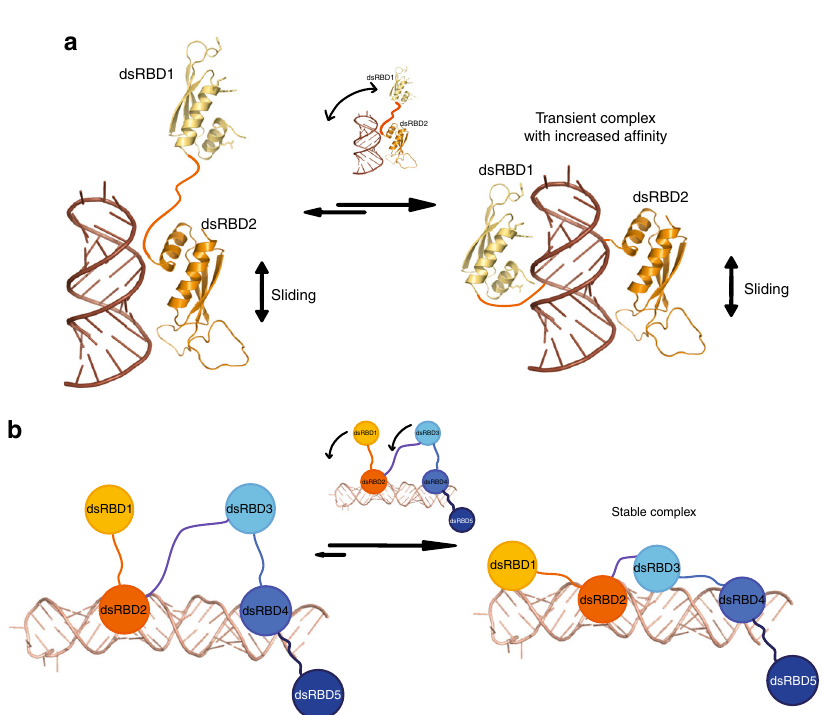
Fig. 6 Functional interaction of mStau2 with oskar mRNA in Drosophila . a Expression of GFP-dmStau, GFP-mStau2, GFP-mStau2[F40A H169A] and GFP- mStau2[F40A F157A] in germline of stau R9 /stau D3 mutant females. In dmStau-expressing oocytes oskar (cyan) localizes almost exclusively to the posterior pole (right) and bicoid (green) to the anterior pole (left) during stage 9 of oogenesis. Transgenic GFP-Stau protein is shown in red. In oocytes lacking Stau ( stau null), oskar is found at both poles, enriching slightly more at the anterior, while bicoid localization is unaffected. Insets show magni fi ed regions of the upper anterior corner. Scale bar: 20 µ m and 1 µ m for insets. b Typical localization of oskar mRNA in oocytes as function of expressed Stau protein. Using image transformation algorithms, RNA signal was redistributed into a 100 × 100 square matrix and statistically evaluated to obtain average (green) and variability (magenta) of RNA distribution. In wild-type oocytes (top left) most signal is found close to the posterior pole (right of the panels) by stage 9. In absence of Stau (stau null), oskar mRNA accumulates at the anterior pole. Scale bar: 20% length of anteroposterior axis. c , d Center of mass (relative to geometric center at 0, c) and fraction at posterior pole of oskar mRNA ( d ) during stage 9. P -values show result of pairwise Mann – Whitney U tests vs. the stau null condition (Bonferroni corrected alpha value: 0.01). N = number of oocytes. Center line: median; box limits: 25 th and 75 th percentile; whiskers: 10 th and 90 th percentile. e – h Interaction of GFP-tagged Stau molecules with oskar ( e , f ) and bicoid ( g , h ) mRNPs. mRNPs are sorted by their mRNA content using quantitative smFISH. Fraction of Stau positive mRNPs ( e , g ) and normalized GFP-Stau signal intensity ( f , h ) were plotted as function of mRNA content of the mRNPs. The normalized GFP-Stau signal intensities are fi tted linear models, with indicated slopes. In pairwise comparisons of oskar mRNPs ( f ), all slopes are signi fi cantly different (p < 0.0001), except for GFP-mStau2[F40A H169A] vs GFP-mStau2[F40A F157A] ( p = 0.016, alpha corrected = 0.01). In bicoid mRNPs ( h ), the slope of GFP-mStau2[F40A F157A] differs from the other three ( p < 0.01), which have similar slopes ( p > 0.9). Source data